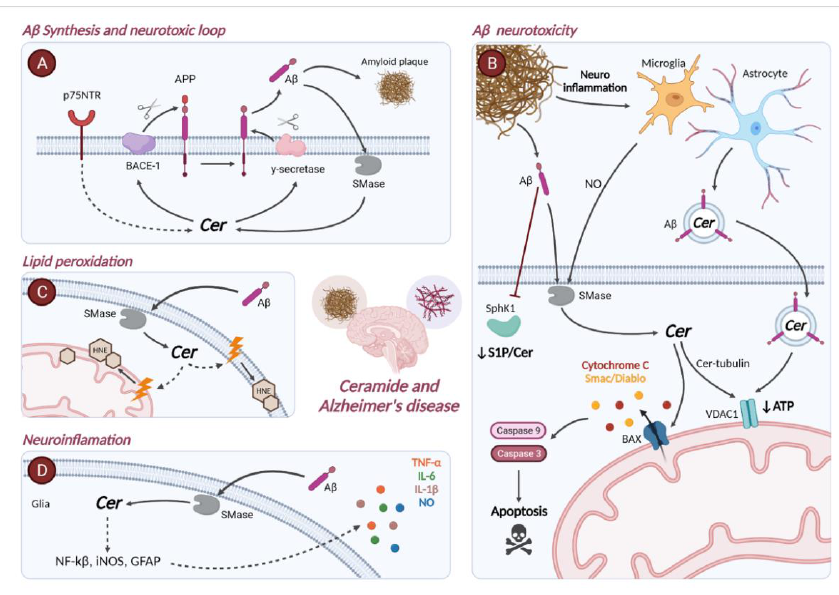
Figure 2. Involvement of Cer in Alzheimer ’ s disease. Several pieces of evidence support the involvement of Cer in the progression of AD, as it is interrelated with the formation of Aβ ( A ) and its neu-